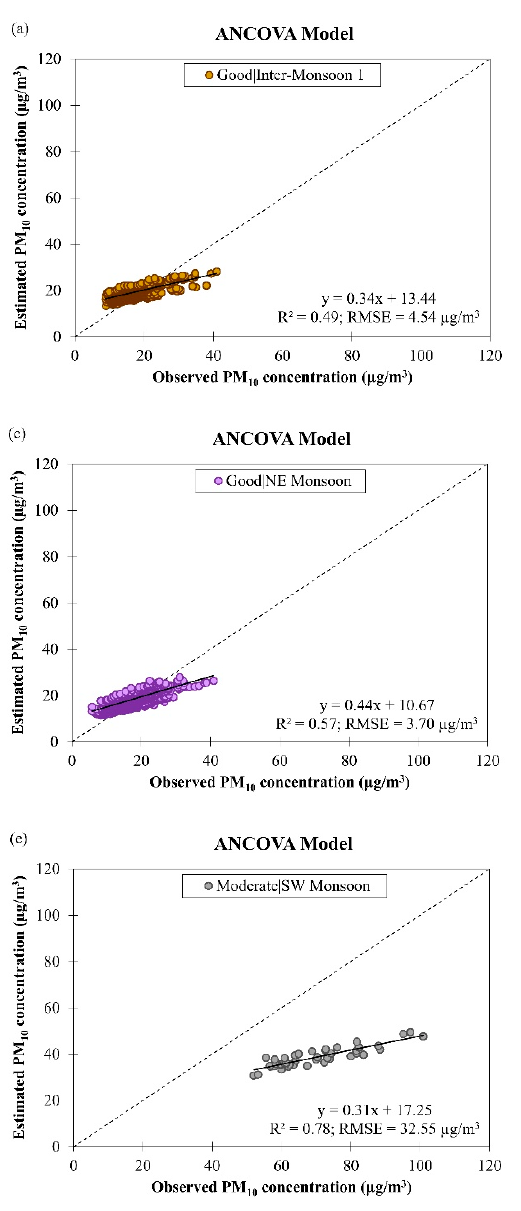
Figure 17. Scatter plots of estimated daily PM 10 concentration against observed daily PM 10 concen- tration by ANCOVA model for ( a – d ) good air quality condition during different monsoon seasons and ( e ) moderate air quality condition during SW monsoon in Brunei Darussalam from January 2009 to December 2019.